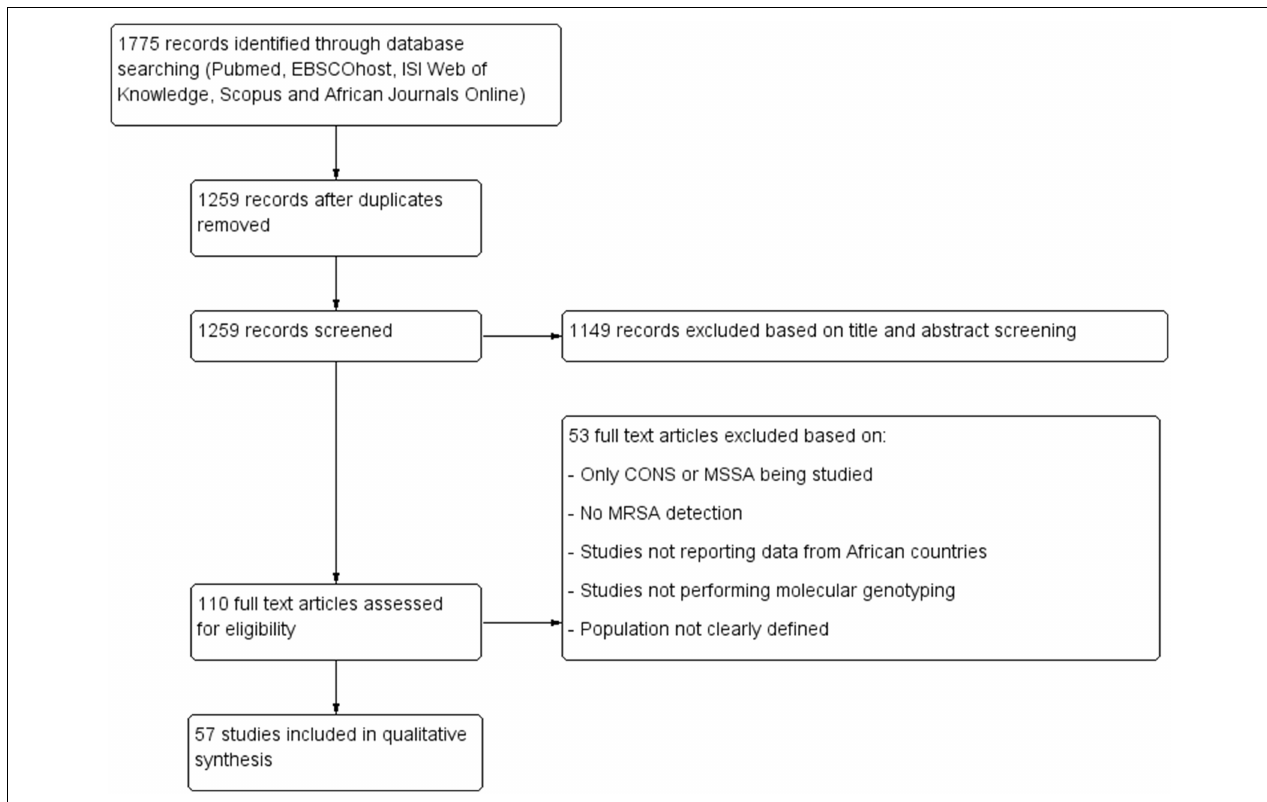
FIGURE 1 | Preferred reporting item for systematic reviews. CONS, coagulase negative staphylococci; MSSA, methicillin susceptible S. aureus; MRSA, methicillin resistant S. aureus.